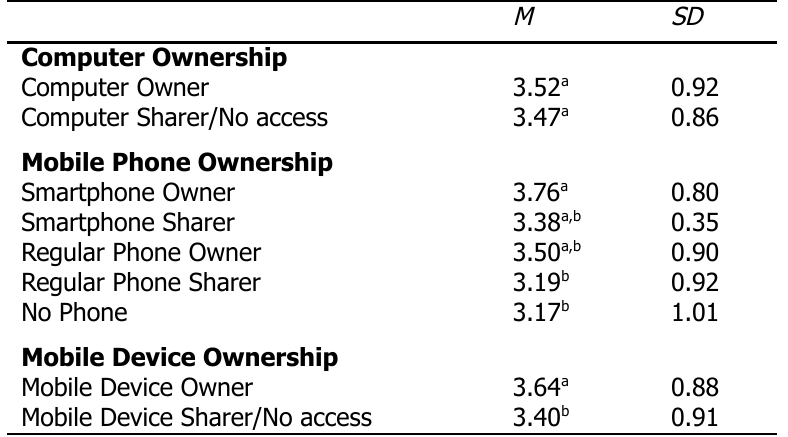
Table 1. Differences between Technology Ownership on Constructive